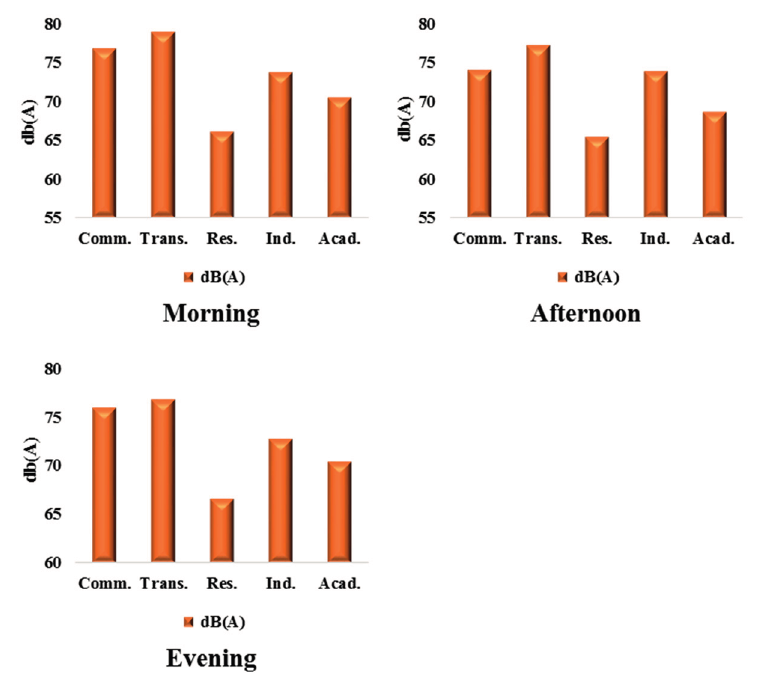
Figure 9. Average noise levels and land use in Ibadan.